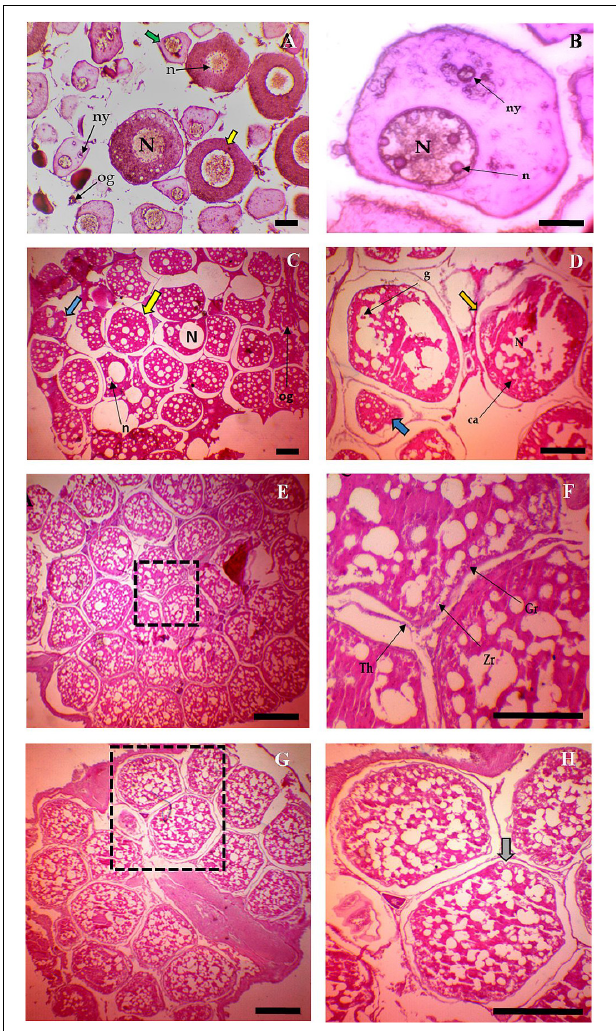
FIGURE 4 | Different stages of Oocyte development in Tenualosa ilisha (A–H) . (A) Section of immature ovary of T. ilisha. Stage of chromatin nucleus (green arrow). Stage of pronucleues (yellow arrow), Nucleus (N), Nucleolus (n), Yolk nucleolus (ny), and Oogonia (og; H & Ex 10); (B) Oocyte in pronucleues stage, Nucleus (N), Nucleolus (n), and Yolk nucleolus (ny; H & Ex 40); (C) Oocyte in cortical alveolus stage. Cortical alveolus stage (Yellow arrow), Cortical alveolus (ca), Pronucleus (Blue arrow), and Oogonia (og). (H & Ex 4); (D) Oocyte in primary vitellogenesis stage. An Oocyte in primary vitellogenesis (Yellow arrow with germinal vesicle in around), pronucleus (Blue arrow), cortical alveolus (ca), Nucleus (N), and Yolk globule (g; H & Ex 40); (E) Oocyte in secondary vitellogenesis, (H & Ex 4); (F) The magnified view of boxed areas of panel (E), Theca (Th), granulosa (Gr), and Zona radiate (Zr; H & Ex 40); (G) Oocyte in tertiary vitellogenesis stage, (H & Ex 4); and (H) The magnified view of boxed areas of panel (G) where gray arrow indicate the tertiary vitellogenesis stage, (H & Ex